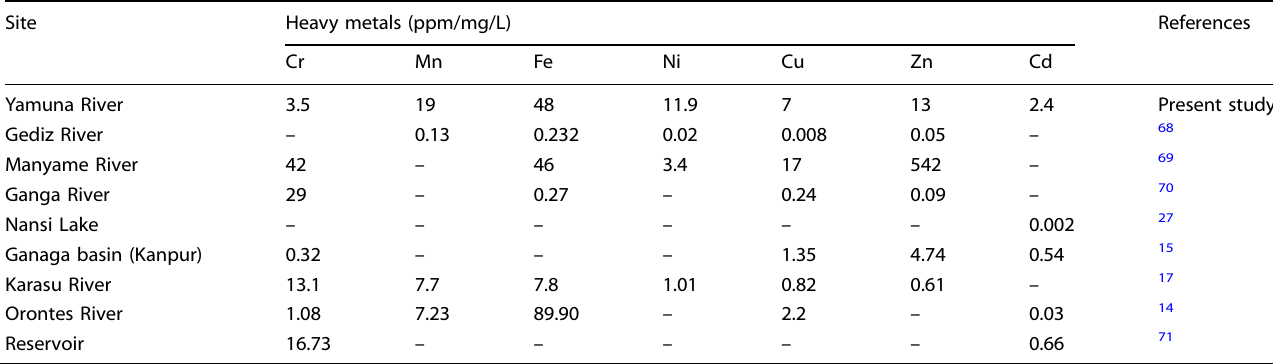
Table 3. Comparative account of water quality status of present study with other water bodies of the world. Site